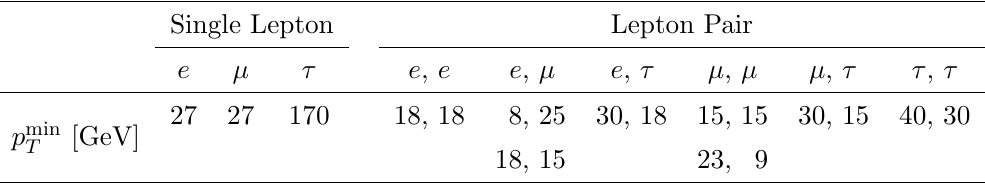
Table 1. Minimal transverse momenta used for the ATLAS single lepton and lepton pair trig- gers